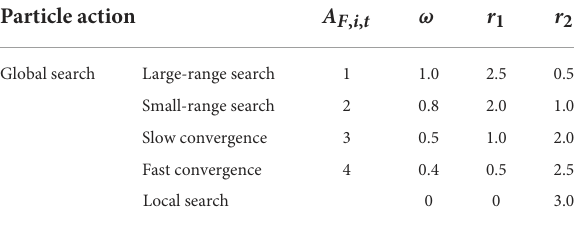
TABLE 2 Target space state.